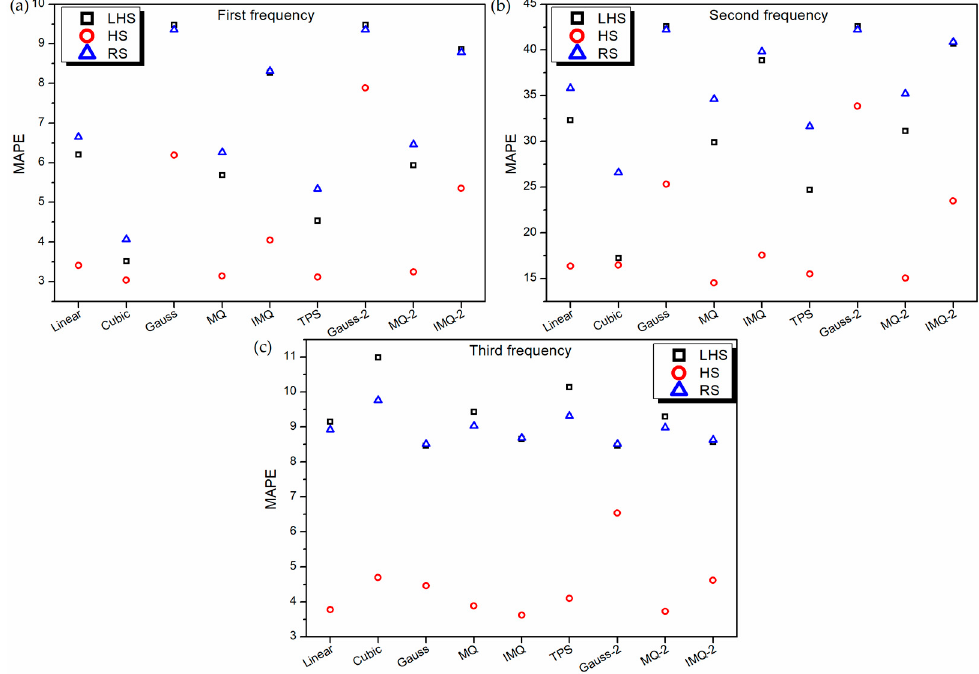
Figure 13. MAPE of various RBF metamodels in HD problem for testing data.